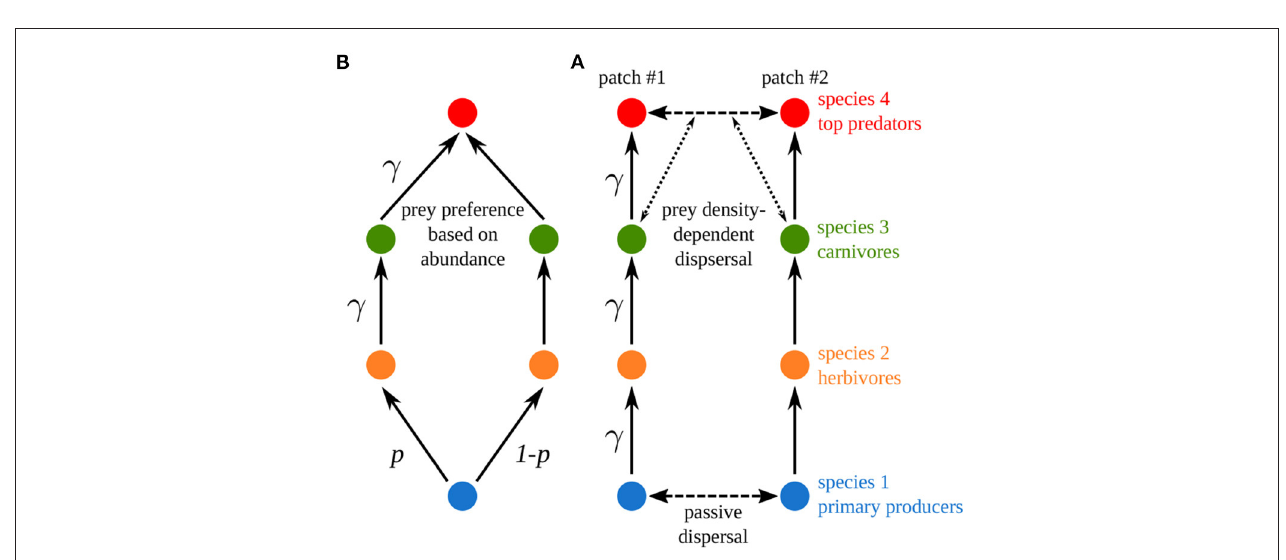
FIGURE 9 | Comparison between (A) Rooney et al.’s and (B) our metacommunity model. γ is the asymmetry of interaction strength and p the fraction of nutrients taken up by resource species in food chain #1 ( p 0.5). Four species are considered: primary producers (species 1), herbivores (species 2), carnivores (species 3) = and top predators (species